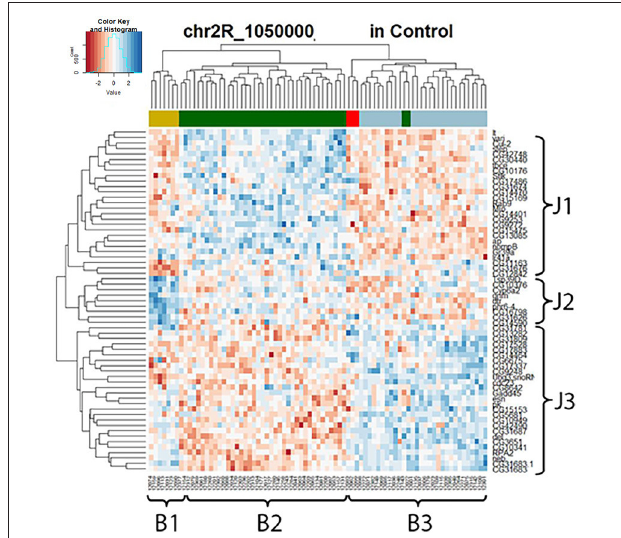
FIGURE 4 | Stable trans- eQTL hotspot at Chr 3R: 5,580,000 ( p- value < 0.05 at 1,000 permutation threshold). Hierarchical clustering analysis was done according to the expression profiles of the Chr 3R: 5,580,000 associated genes ( p -value < 0.05). Plotted by using the lead-specific trans- eQTL, the bottom list indicates all the sample names and the right list indicates all the associated genes. The color-coded bar above the heatmap and below the dendrogram indicates the original parent of each sample listed at the bottom for this specific location. Color legend in the color-coded bar: red: A1, green: A2, blue: A3, dark green: A4, light blue: A5, purple: A6, gold: A7, darkgray: